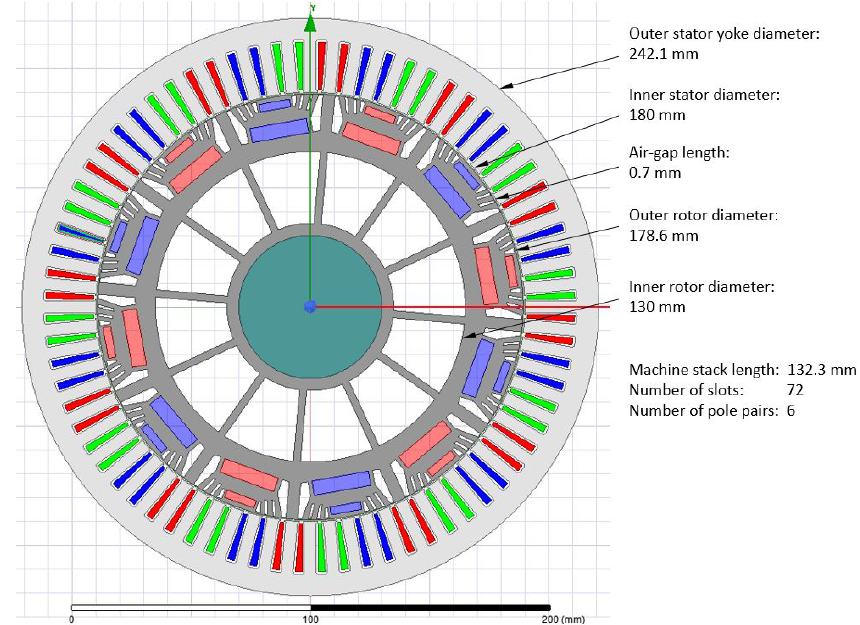
Figure 1. The BMWi3 traction machine geometry view and its main